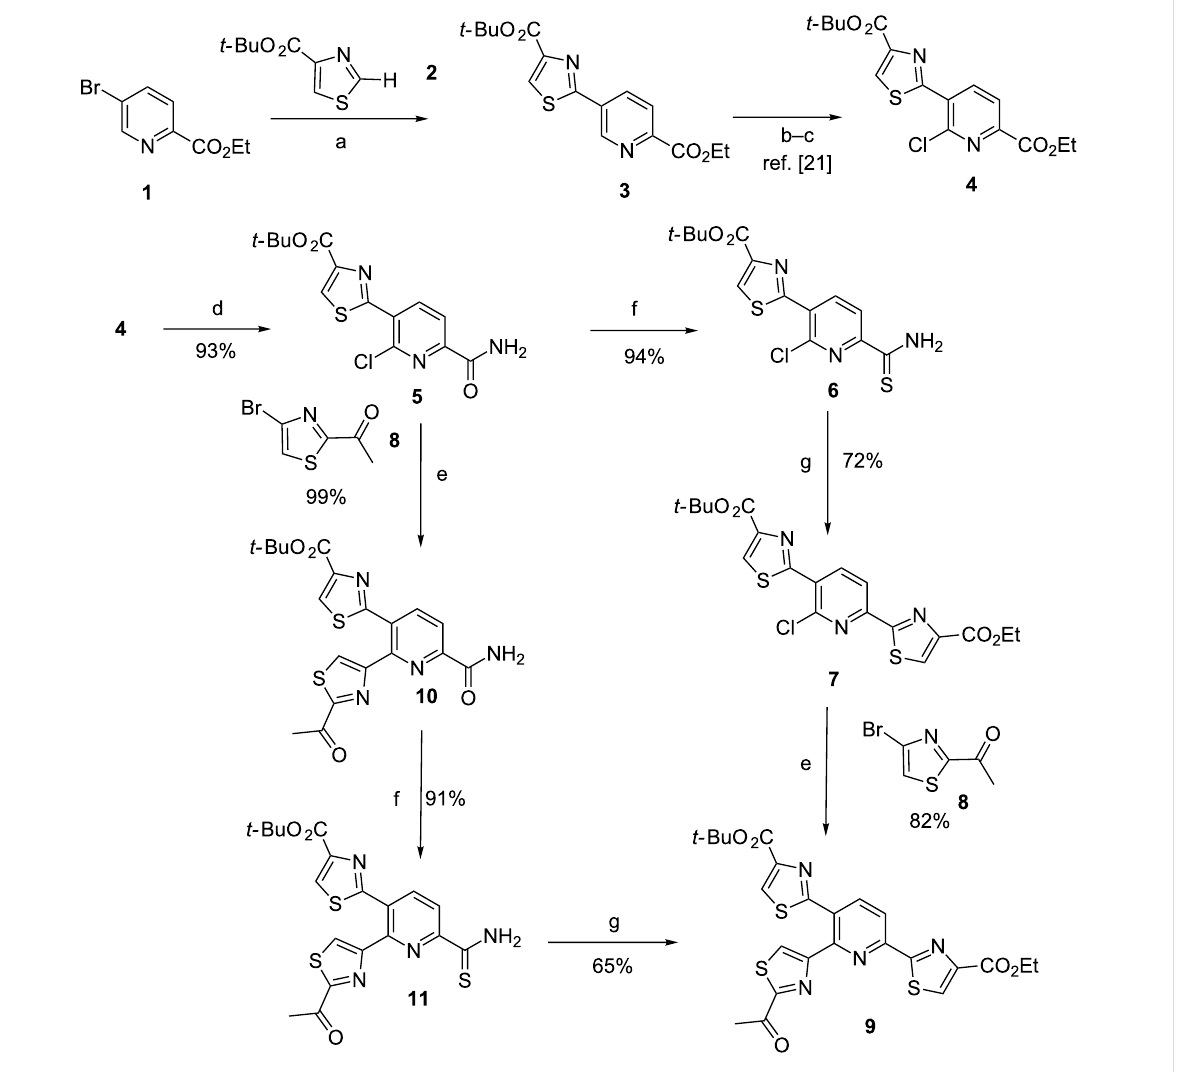
Scheme 1: Synthesis of trithiazolylpyridine 9 . Reaction conditions: a) Pd(OAc) 2 (5 mol %), CyJohnPhos (10 mol %), Cs 2 CO 3 (2 equiv), DMF, 110 °C, 18 h, 69%. b) UHP (2 equiv), TFAA (2.1 equiv), ACN, 0 °C, 1 h, quantitative. c) POCl 3 (2 equiv), toluene/DMF, 0 °C, 1 h, 83%. d) NH 4 OH, THF/H 2 O (2:1), rt, 14 h, 93%. e) (i) 8 , Bis(pinacolato)diboron, Pd(OAc) 2 (5 mol %), CyJohnPhos (20 mol %), KOAc, dioxane, 1 h; (ii) K 3 PO 4 , dioxane/H 2 O (4:1), 110 °C, 14 h, 82–99%. f) Lawesson’s reagent, CH 2 Cl 2 , 40 °C, 12 h, 91–94%. g) Ethyl bromopyruvate, CaCO 3 , THF/EtOH (1:1), 60 °C, 24 h.